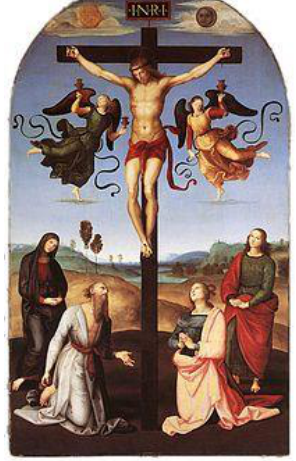
Fig. 11 The crucifixion, Raphael (1520)